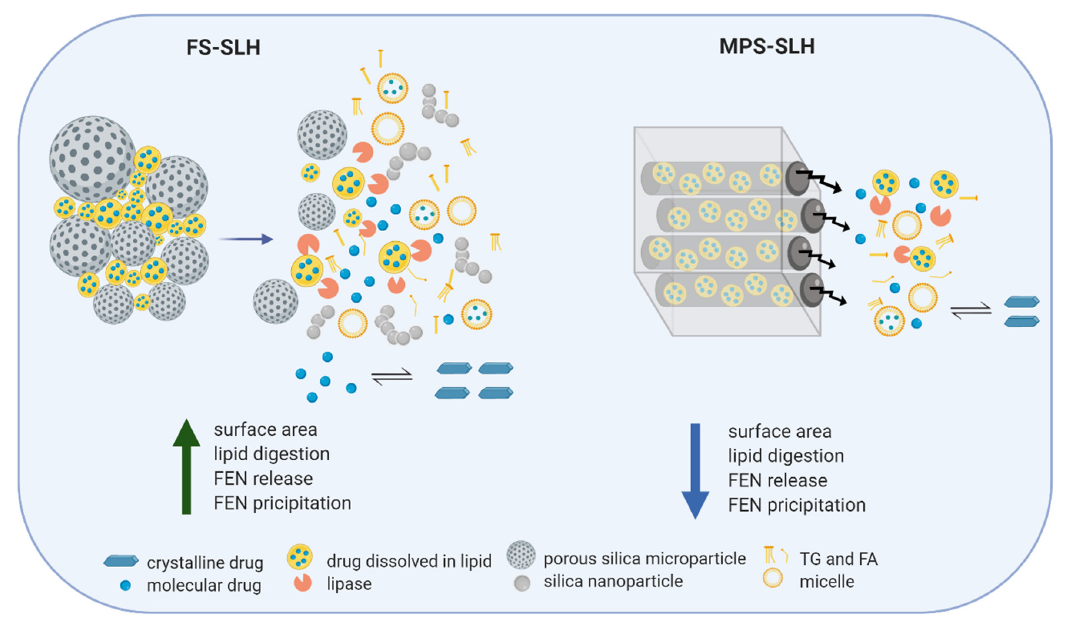
Figure 8. A schematic representation of the proposed mechanism of FEN release and precipitation from SLH made with FS and MPS, during in vitro lipolysis. Created with BioRender.com.